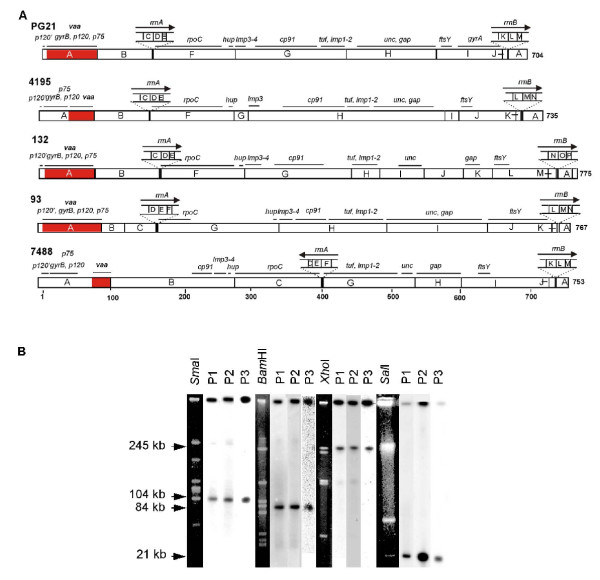
Mapping the vaa gene. The vaa gene was mapped on existing physical and genetic maps using pulsed field gel electrophoresis and Southern blotting [8]. A: the location of the vaa gene on the physical maps of five M. hominis isolates PG21, 4195, 132, 93 and 7488. The vaa gene mapped to the same genomic region for all isolates (shown in red). B: Pulsed field gel electrophoresis and Southern blotting results used for mapping of vaa in M. hominis 7488. Digests of four out of five enzymes used is shown. The probes 1 to 3 are denoted P1 to 3. The sizes of the bands reacting with the probes are indicated on the left side of the figure.